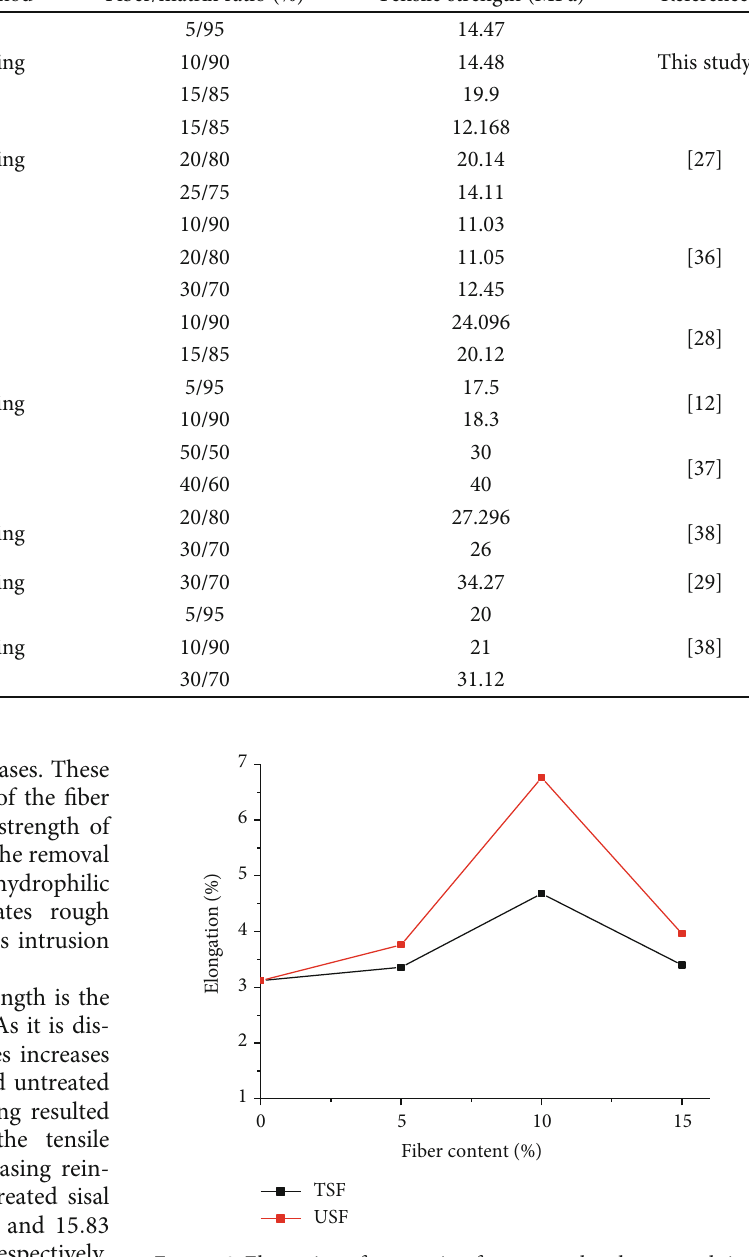
Figure 8: Elongation of composites from treated and untreated sisal fi